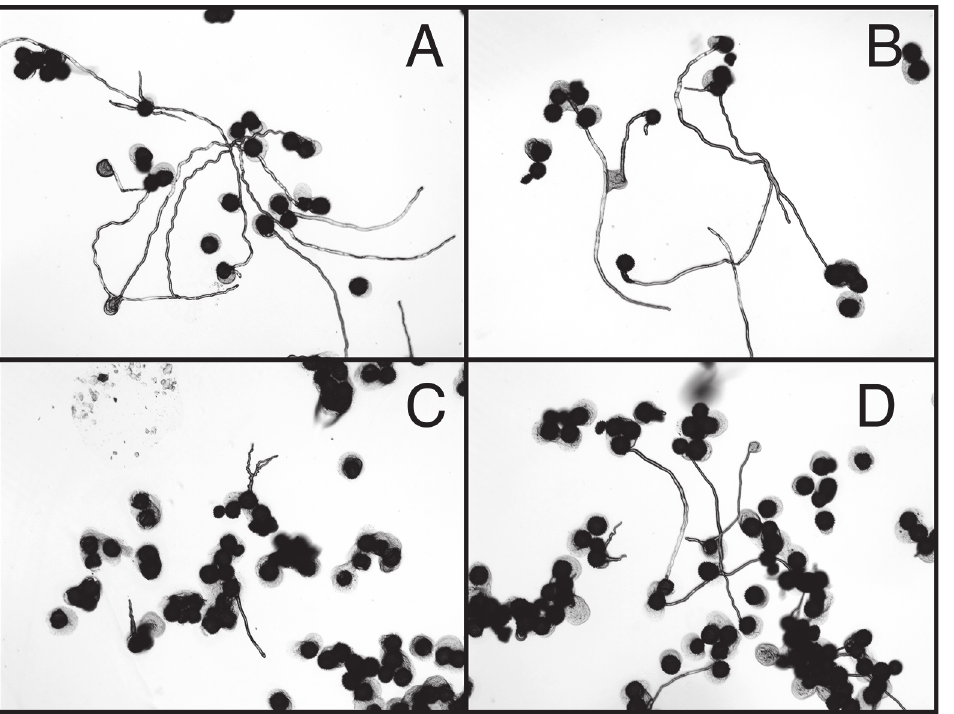
Fig 10. Photomicrographs of cotton pollen following a high temperature challenge. Representative photomicrographs showing pollen germination at 28°C according to the procedure described by Burke et al. [17] from plants grown under control temperatures (31°C/27°C day/night temperatures) and elevated temperatures (43°C/28°C day/night temperatures). (A) Plant 52 Control, (B) Plant 40 Control, (C) Plant 52 from a greenhouse with elevated day/ night temperatures, (D) Plant 40 from a greenhouse with elevated day/night temperatures.